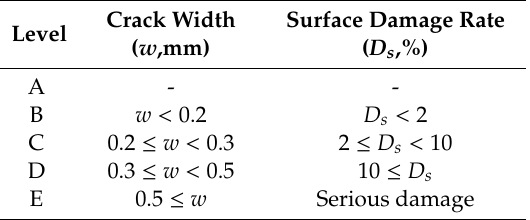
Table 5. Condition level evaluation criteria of the PSC-I girder [17].